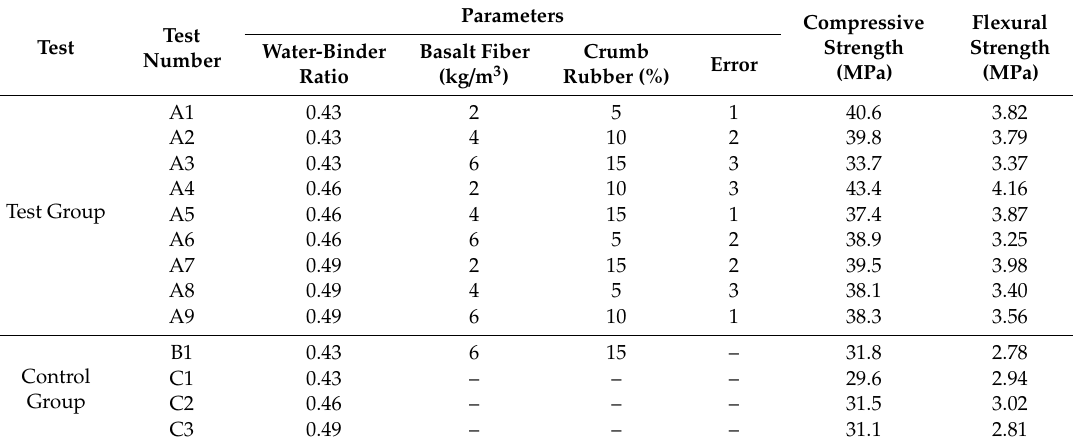
Table 7. The experimental results of compressive strength and flexural strength tests.